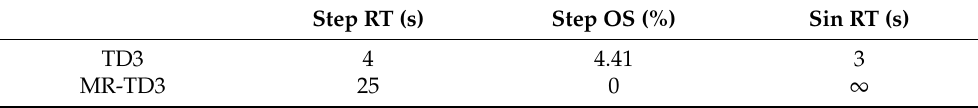
Figure 10. The pitch channel response error of TD3 and the MR-TD3 agent. The error is the deviation between the reference target value and the actual agent response value. The step pitch response is ( a ) and the sine pitch response is ( b ). Table 4. Comparison of the response time and overshoot in pitch